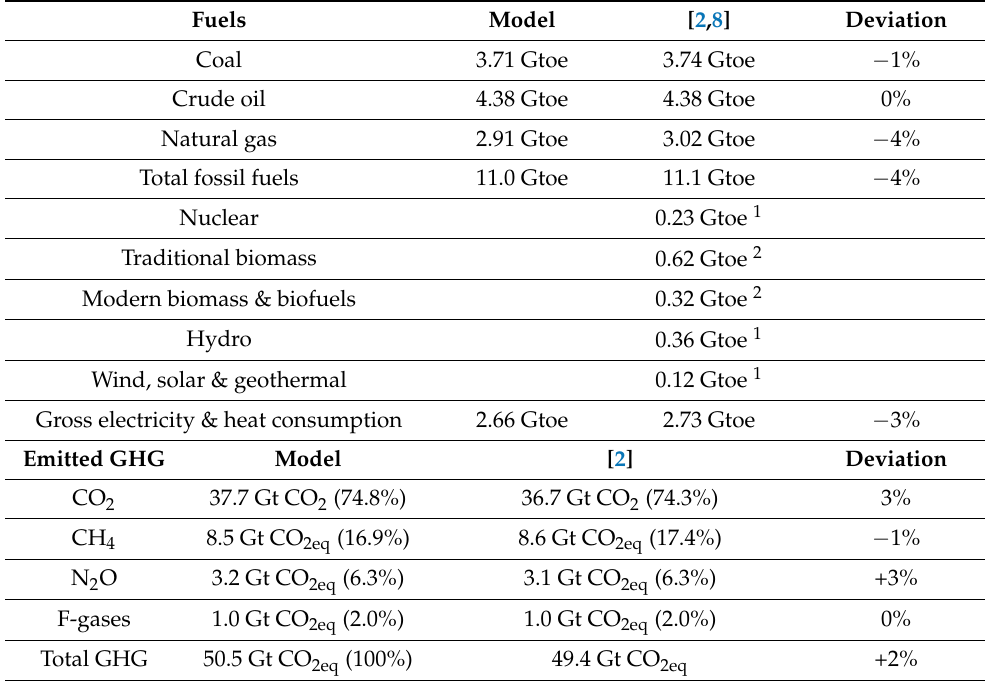
Table 5. Comparison of global energy data and GHG emissions 2016 of model and literature [2,8].